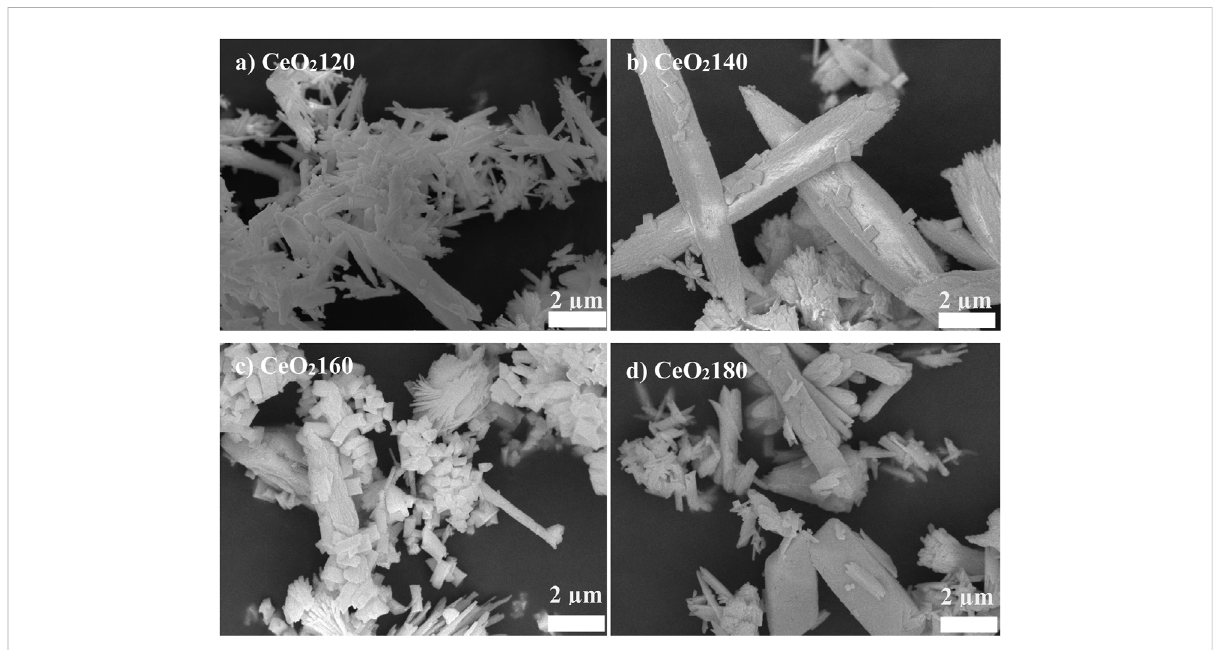
FIGURE 1 Representative scanning electron microscopy images of (A) CeO 2 120, (B) CeO 2 140, (C) CeO 2 160, and (D) CeO 2 180. Scale bar: 2 µm. The reported images are representative of those obtained from at least three such fi elds of view and two independent samples. CeO 2 X: cerium oxide obtained at a value X for the temperature of the preparatory hydrothermal